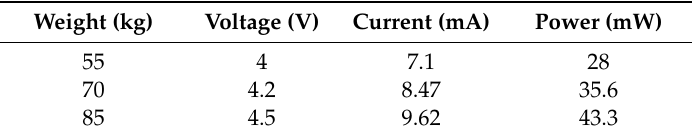
Table 5. Voltage, current, and power obtained for the footfall of people with different weights.